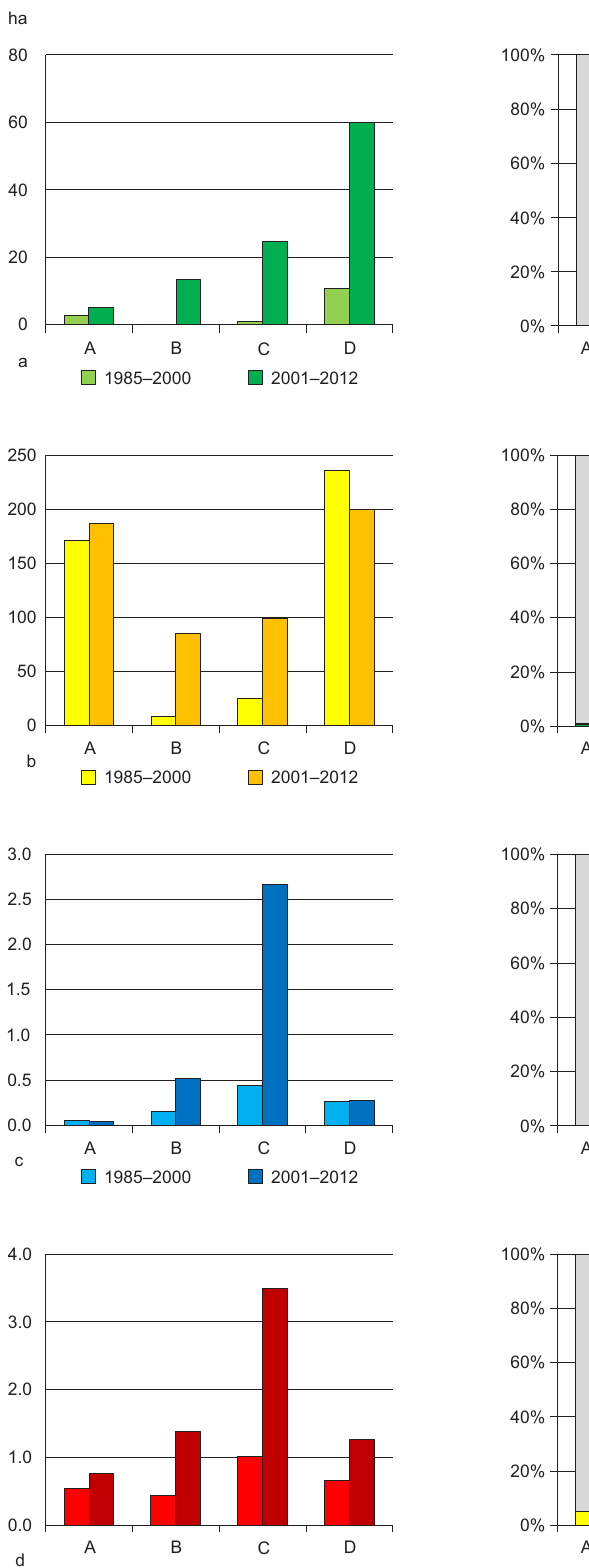
Fig. 5. loss [ha] of forest (a), grassland (b), water (c) and built-up areas (d) in testing grounds A–D and the share of [%] types of land cover, which in the years 1985–2000 and 2001–2012 were transformed into: 1 – forests, 2 – grassland, 3 – water, 4 – built-up areas, 5 – other type of cover. Source: own